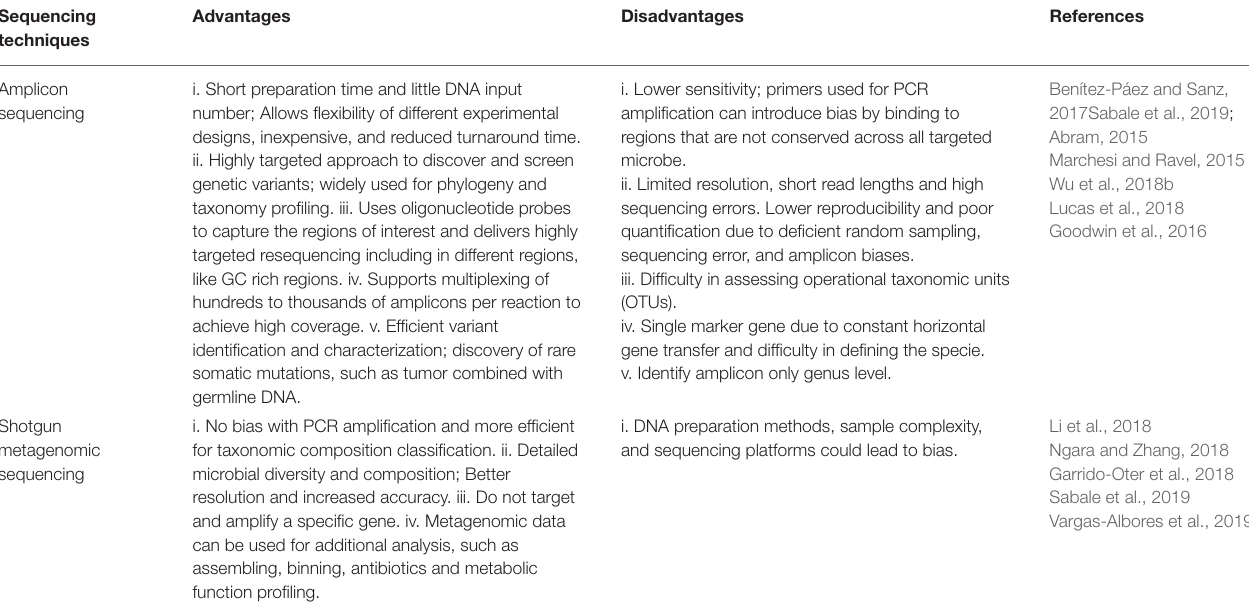
TABLE 2 | Some advantages and disadvantages of amplicon and shotgun metagenomic